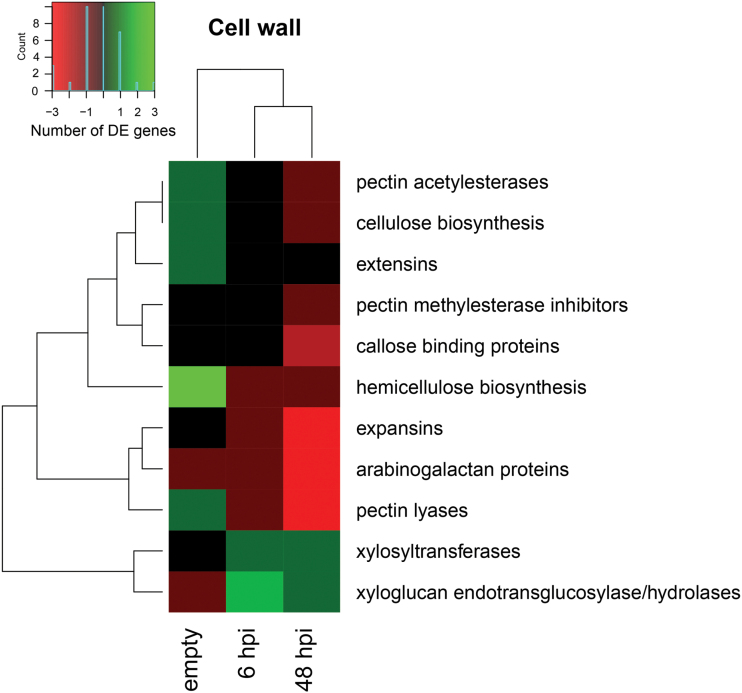
Expression of cell-wall related genes in wrky22-3 and the effect of mechanostimulation by empty clip cages and aphid infestation. Genes and treatments are clustered according to the number of differentially expressed genes (≥2-fold change), using Ward’s minimum variance method (red: down-regulated; green: up-regulated in wrky22-3 compared with the wild-type).